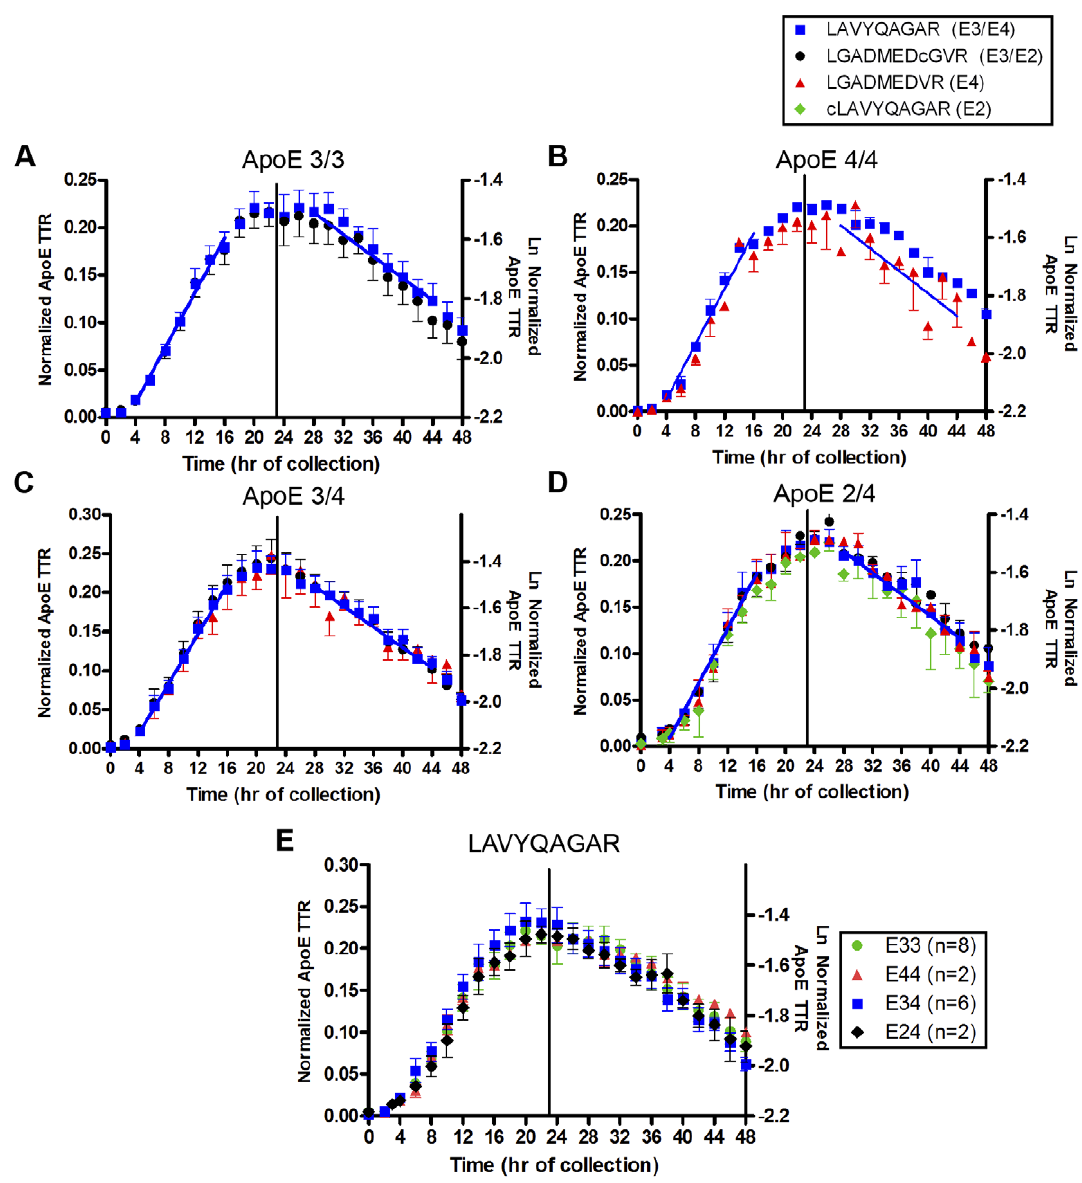
Figure 3. 13 C 6 -leucine labeling in CNS-ApoE isoforms in cognitively-normal young individuals. 13 C 6 -leu incorporation into ApoE isoform- specific peptides was quantified by nanoLC/MS/MS. The ratios of the labeled to unlabeled ApoE were normalized to the plasma 13 C 6 -leu precursor levels during the production phase (h0–22) to reduce inter-subject variability due to differential TTR of plasma leucine precursor. Individuals were grouped by genotype and their averages are shown in A–D : A , E3/3 (n=8); B , E4/4 (n=2); C , E3/4 (n=6); D , E2/4 (n=2) (blue square: LAVYQAGAR, black circle: LGADMEDVcGR, red triangle: LGADMEDVR, green diamond: cLAVYQAGAR.). The linear regression of the means for h4–16 and h28–44 is shown for LAVYQAGAR to demonstrate the time points used for each individual’s FSR and monoexponential slope FCR calculations. E. The averages of the common peptide (LAVYQAGAR) for all four genotypes (n=18) were compared (green circle: E3/3; red triangle: E4/4; blue square: E3/4; black diamond: E2/4). Error bars represent standard error of the mean (SEM).